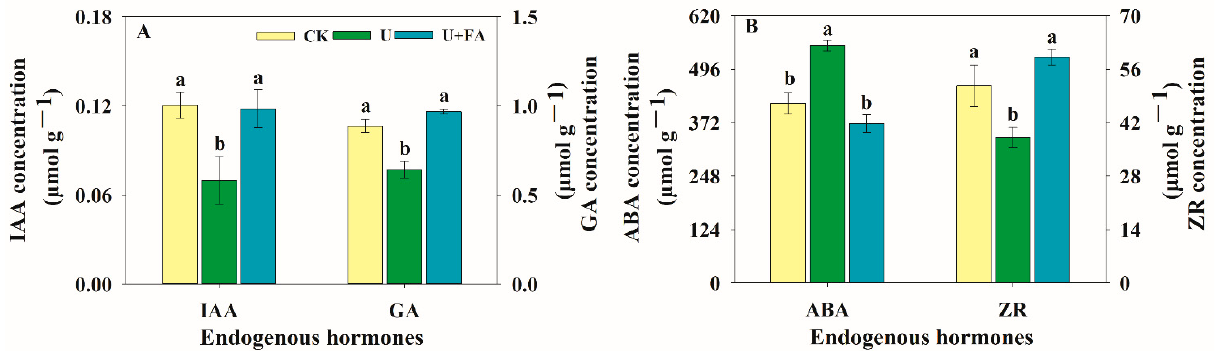
Figure 3. Effects of different fertilization treatments on the concentrations of auxin (IAA, ( A )), gibberellin (GA, ( A )), abscisic acid (ABA, ( B )) and zeatin nucleoside (ZR, ( B )) in maize leave at the jointing stage, in 2018. The treatments include: no nitrogen fertilizer (CK); application of urea (U); combined application of urea and fulvic acid solution (U+FA). The values are means of four replicates, and the error bars are standard errors. Different letters indicate significant differences between treatments for a same parameter according to SNK’s test at p < 0.05.